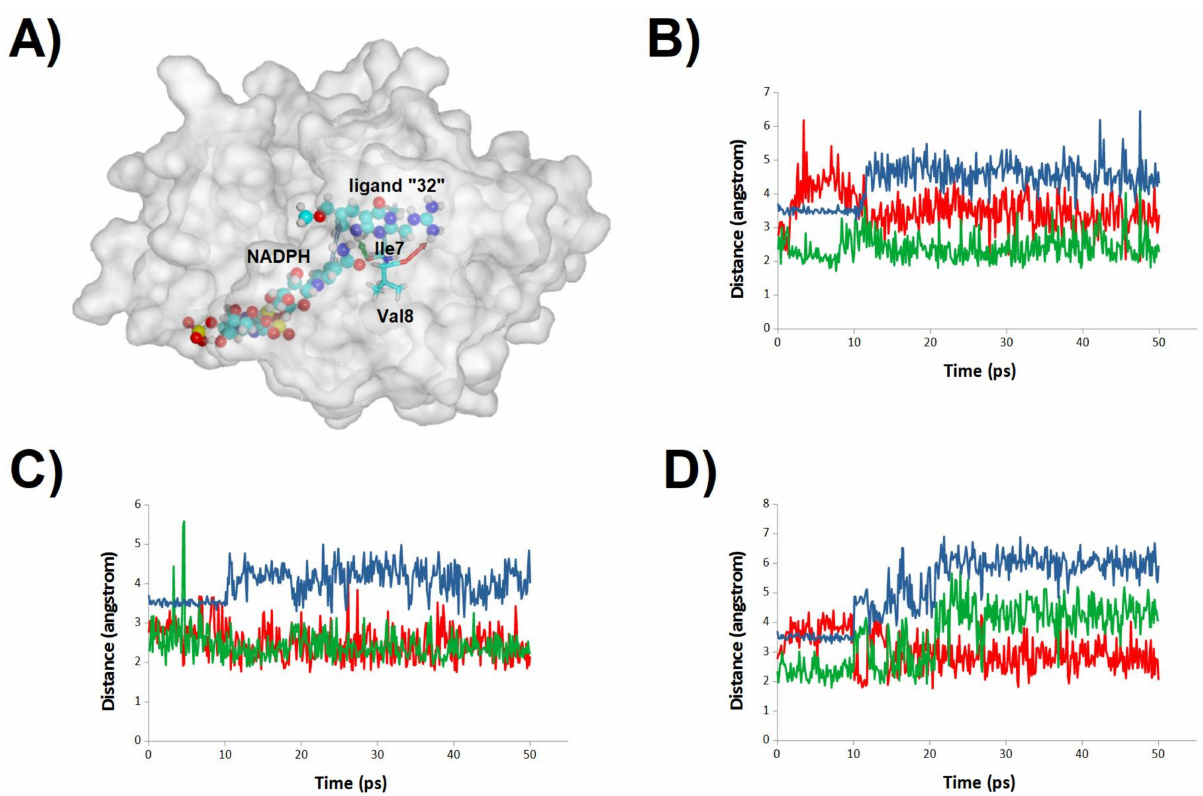
Figure 10. Stability of the binding mode of molecule 32 at the human DHFR active site. ( A ) Represen- tative snapshot of a trajectory of ligand-bound human dihydrofolate-bound DHFR; ( B – D ) evolution of key ligand-protein distances in three simulations. Each line in the graph corresponds to the evolution of the distance between the atoms connected with an arrow of the same color in panel ( A ): blue for NADPH:ligand distance, red for the Val8 carbonyl:guanidinium distance and green for the Ile7 carbonyl:ligand N 1 -atom